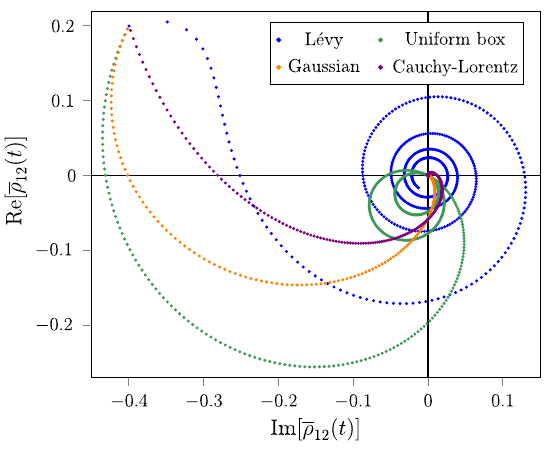
FIG. 5. Ensemble-average dynamics of a single qubit with spectral disorder. Shown are the dynamics of the coherences in the Bloch sphere representation, i.e., the real and imaginary parts of the off-diagonal terms of the averagedensity matrix ¯ ρ 12 ð t Þ ¼ ¯ ρ (cid:4) 21 ð t Þ [cf. Eq. (31)], for the Cauchy-Lorentz, Gaussian, and Lévy dis- tributions, with coinciding scale parameter σ , and, for visual clarity, for the uniform box distribution with 2 σ . The initial parameters are chosen as in Fig. 2, yielding ρ 12 ð 0 Þ ¼ 1 = 5 − i 2 = 5 . Time runs from − 1 . All four distributions lead to t ∈ ½ 0 ; 3 π (cid:2) in units of ð σω 0 Þ the disorder master equation (28), but they follow distinct trajecto- ries determined by the respective decoherence rates and energy functions (38), (40), (42), and (44). In particular, one can see the the Lévy distribution (44) in the accelerating coherent precession frequency (blue line), as compared to the constant precession frequency for the three other distributions.